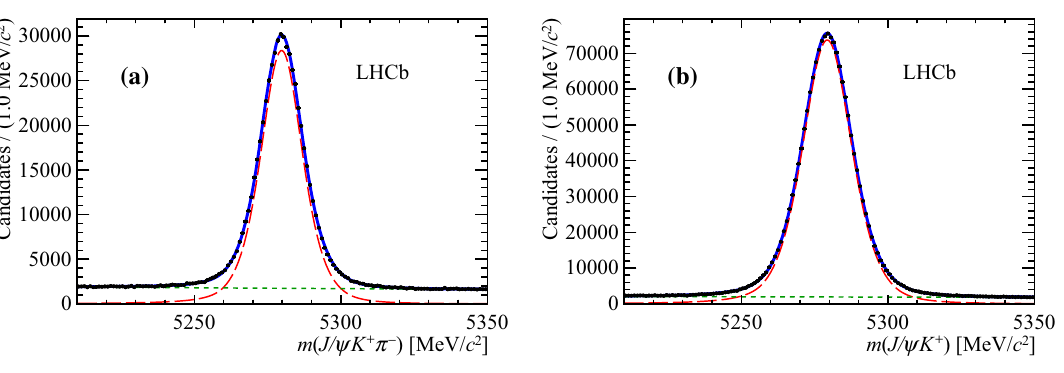
by the long-dashed red line, the background component by the dashed green line and the total fit function by the solid blue